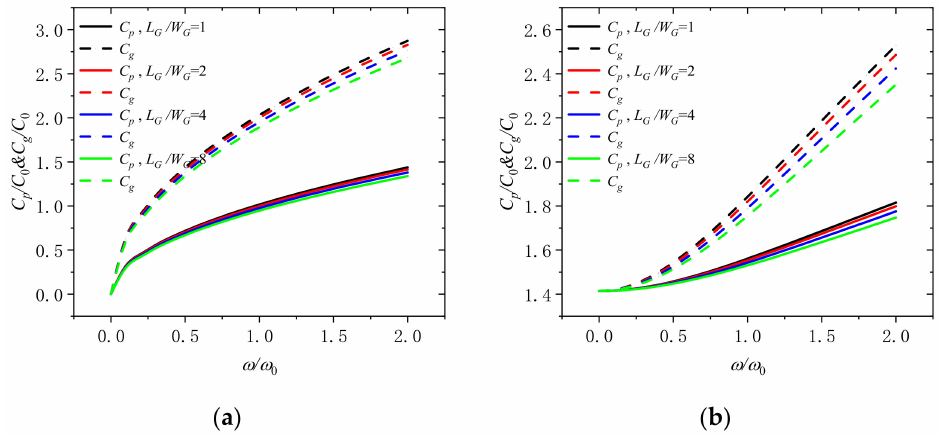
Figure 8. Phase speed and group speed in a rotating microbeam with different length width ratio of GPLs ( L G / W G = 1, 2, 4, and 8) for ( a ) Ω / Ω 0 = 0 and ( b ) Ω / Ω 0 = 2.